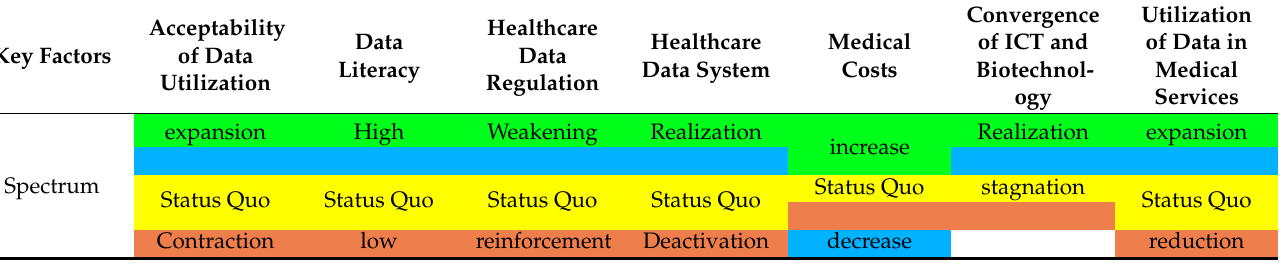
Table 7. Results of GMA scenario (expert evaluation